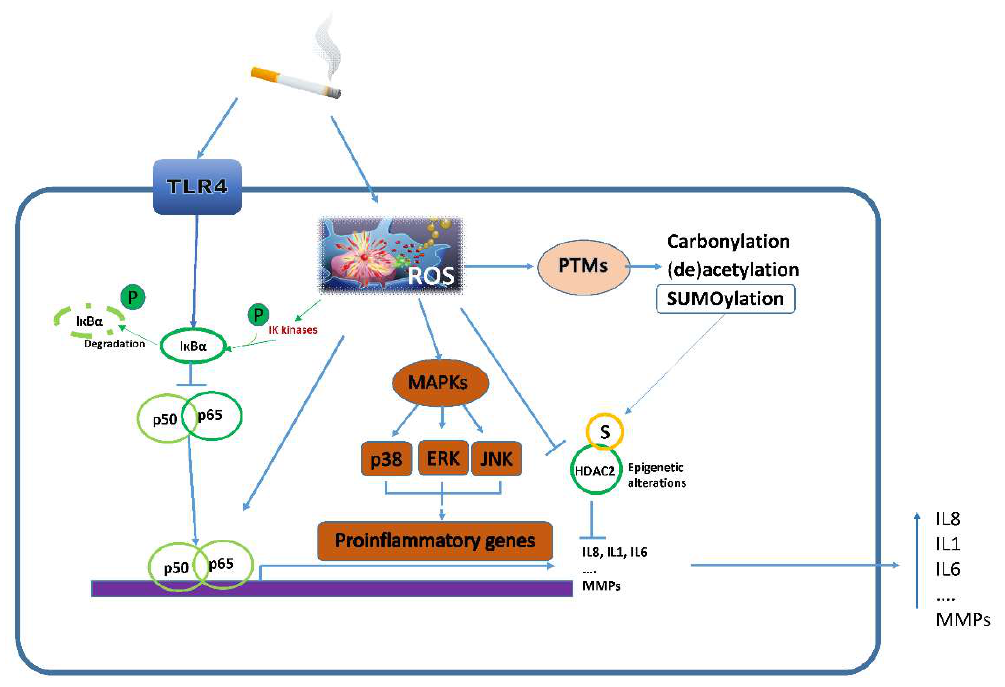
Figure 3. Molecular mechanisms altered by cigarette smoke in bronchial epithelial